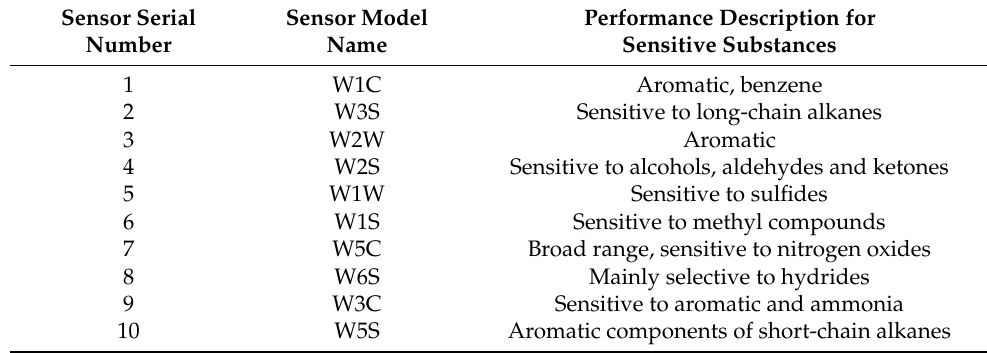
Table 4. Sensors used and their main application in the PEN3